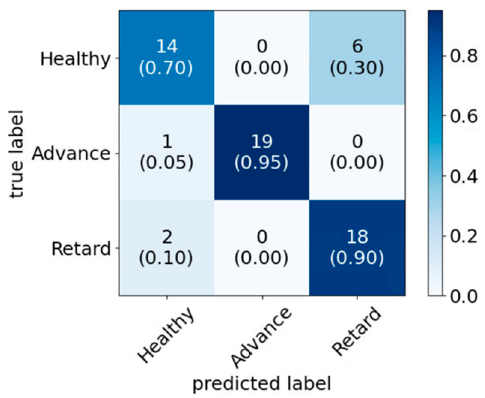
Figure 10. Model 2—confusion matrix for ignition timing variation data.